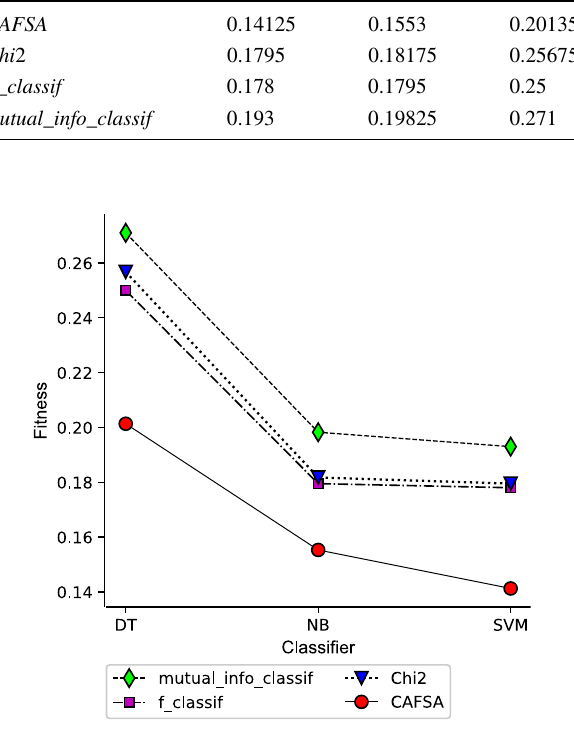
Fig. 16 Chi-square test and CAFSA performance on ChnSenticorp_ NoteBook data